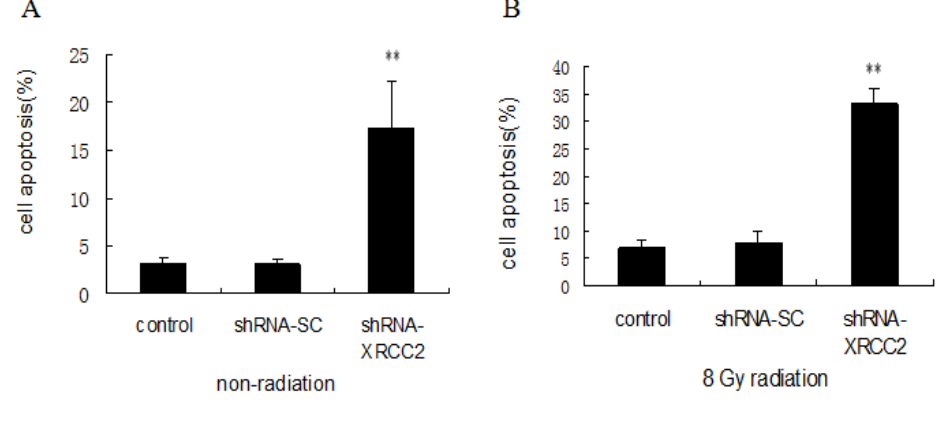
Figure 6. Knockdown of XRCC2 enhanced cell apoptosis after radiation treatment. ( A ) Cell apoptosis without exposure to radiation; and ( B ) cell apoptosis after exposure to 8 Gy radiation. Cells were transfected with either shRNA-XRCC2 or shRNA-SC. Cells were irradiated with 8 Gy at 12 h after transfection. The effect of XRCC2 suppression on cell apoptosis in T84 cell line was examined by flow cytometric analysis. The values are presented as the mean ± SD ( n = 5). ** p < 0.01 compared with the control